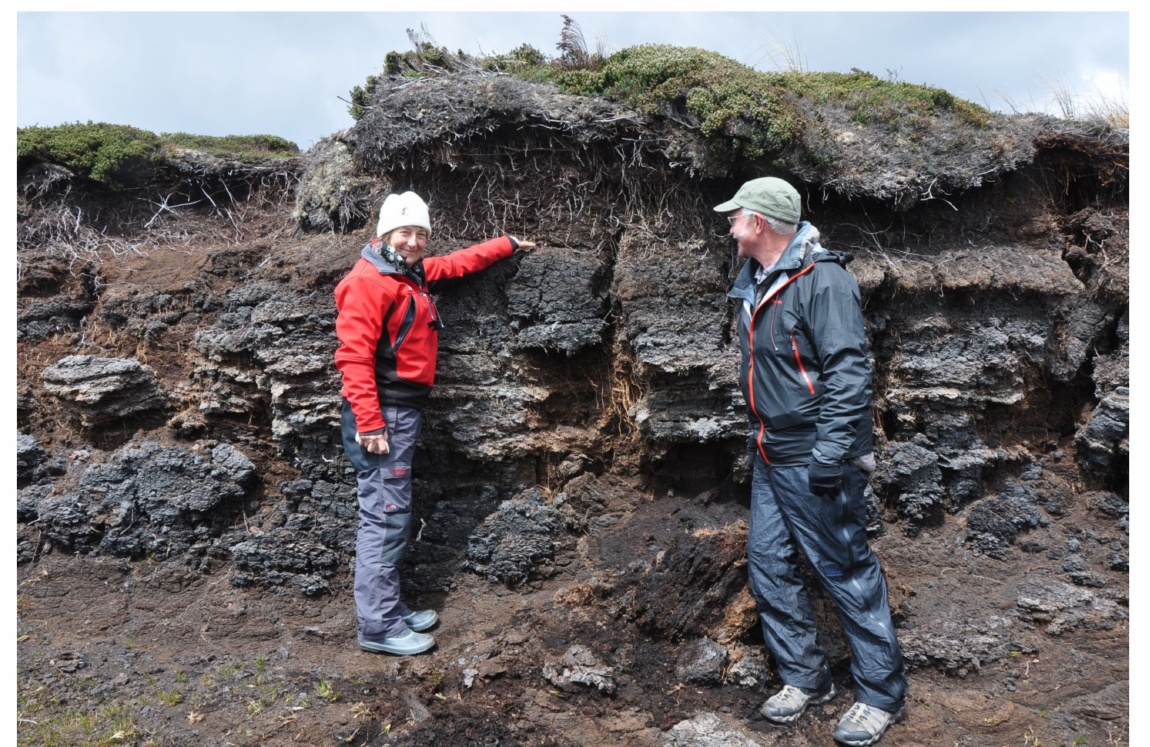
Figure 13. Exposed eroding face of the peat ‘bank’ at Goat Ridge, Falkland Islands. Source: Ed- ward